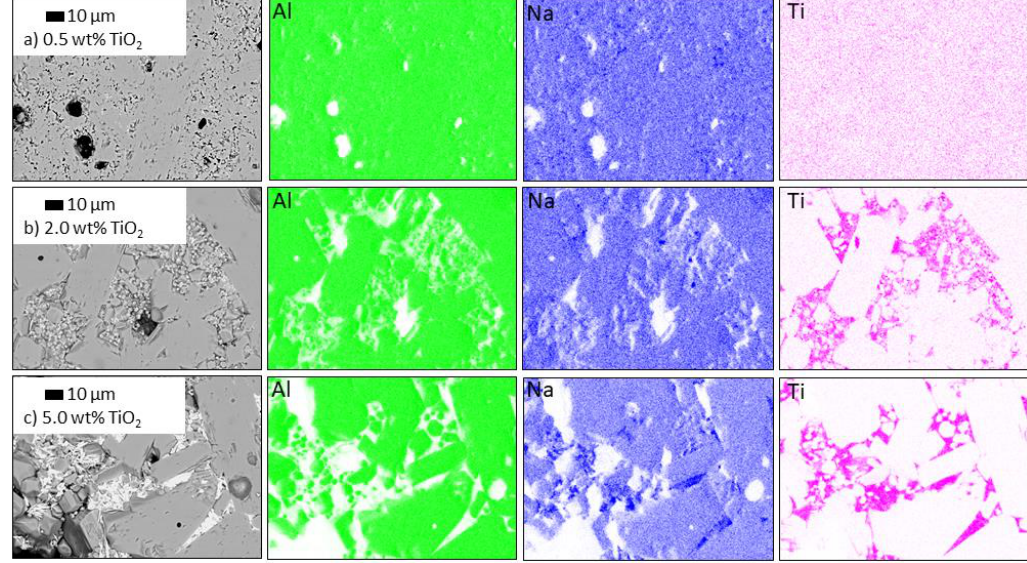
Figure 9. EDX mapping and backscattering SEM images of TiO 2 -doped, polished Na- β″ -alumina samples (sintered at 1600 °C). ( a ) 0.0 wt% TiO 2 ( b ) 2.0 wt% TiO 2 ( c ) 5.0 wt% TiO 2 . Al is labeled green; Na is labeled blue; Ti is labeled pink.